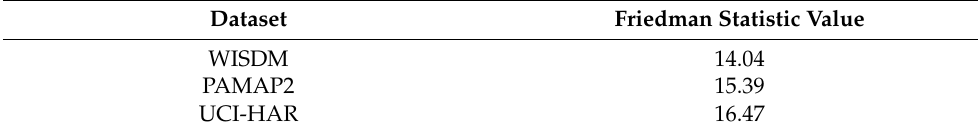
Table 5. Calculated value of Friedman statistic for each HAR dataset.